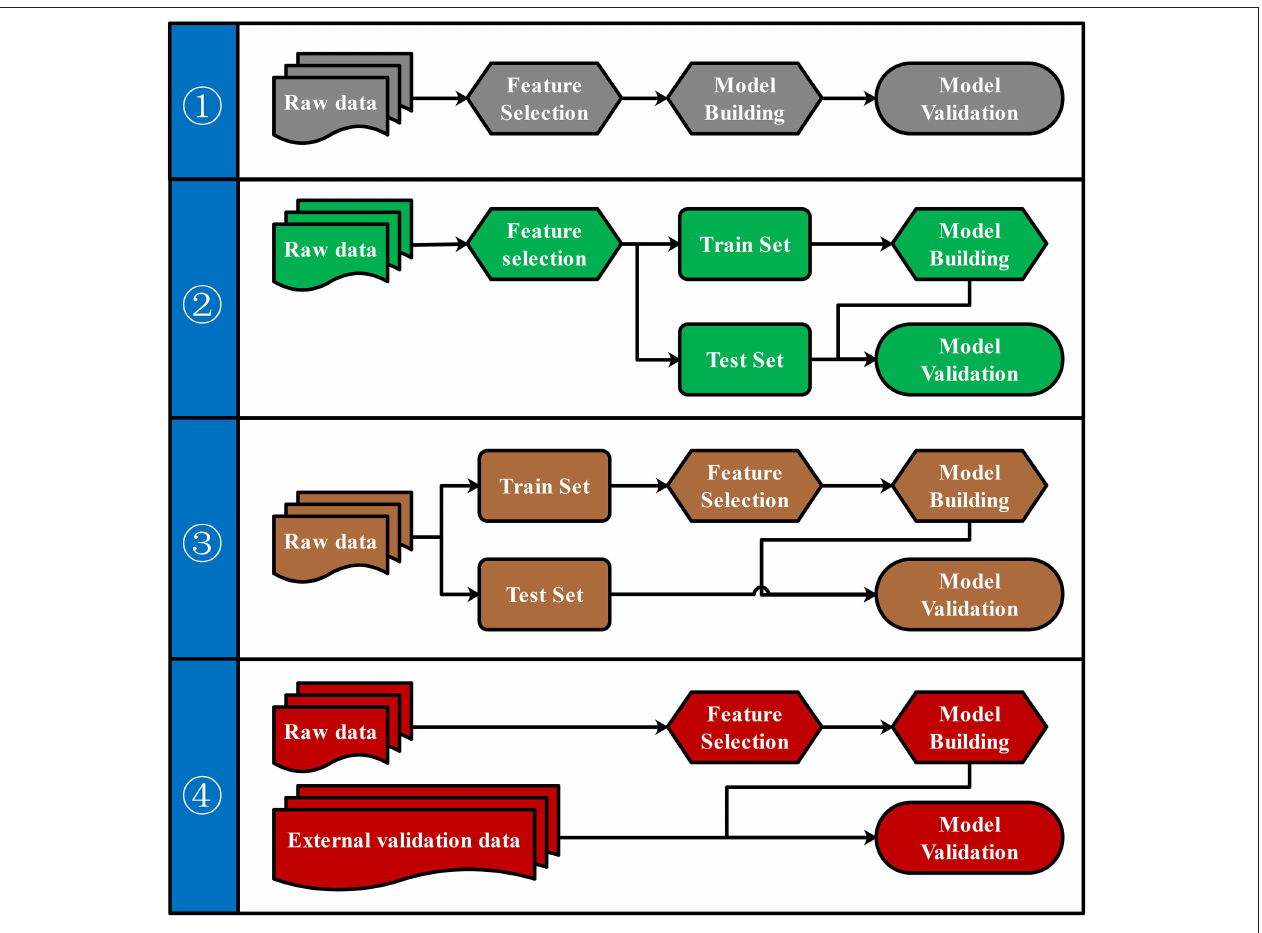
edge table and node table into Cytoscape to perform more personalized